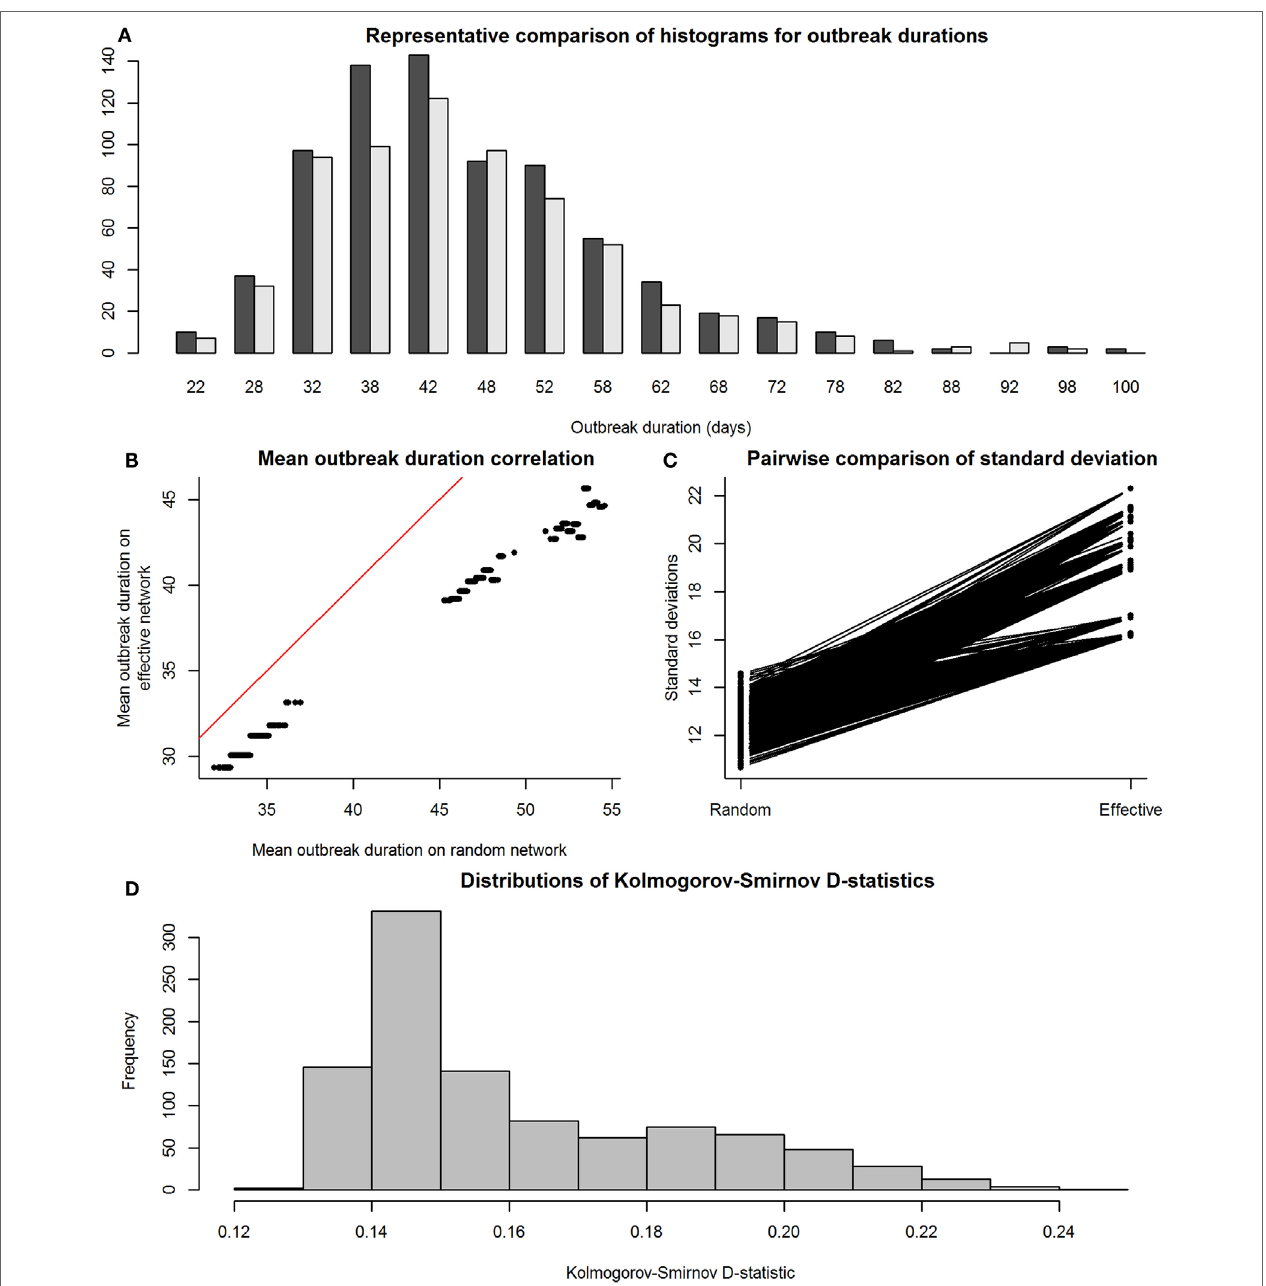
FIGURe 5 | Comparison between distributions of outbreak durations for susceptible-infected-recovered simulations on observed and effective network. Again, the term “observed” refers to results from simulations on Erdo´´s-Rényi graphs, and “effective” refers to results from simulations on reduced major axis-predicted equivalent maximally complete networks. Network sizes are also limited to a maximum of 80 individuals, as this was the condition under which we were reasonably confident in our results. Panel (A) , a histogram with a representative pair of observed (dark gray) and effective (light gray) distributions of outbreak durations plotted together for viewing overlaps, shows that the distributions, compared on a pairwise scale had a considerable amount of overlap. Panel (B) shows means of outbreak durations from observed networks plotted against those from their predicted effective networks; red line indicates 1:1 equivalence, at which effective means match observed means. Panel (C) shows a paired line plot of SDs in outbreak durations for simulations on observed and effective networks; observed networks showed higher SDs than their paired effective networks. Panel (d) shows a histogram of Kolmogorov–Smirnov D-statistics for pairwise statistical comparisons between observed and effective network outbreak durations, with values above 0.60 indicating significantly different distributions.